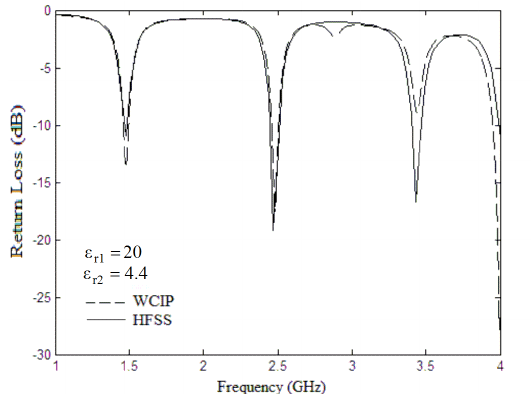
Figure 7: Return loss versus frequency for circular patch antenna.